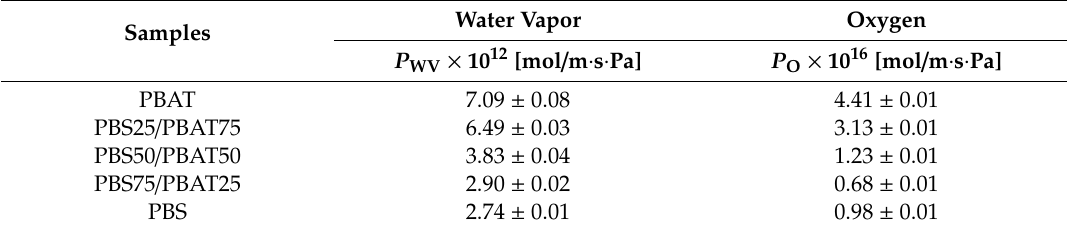
Table 5. Water vapor and oxygen gas permeabilities of PBAT, PBS and their blends.